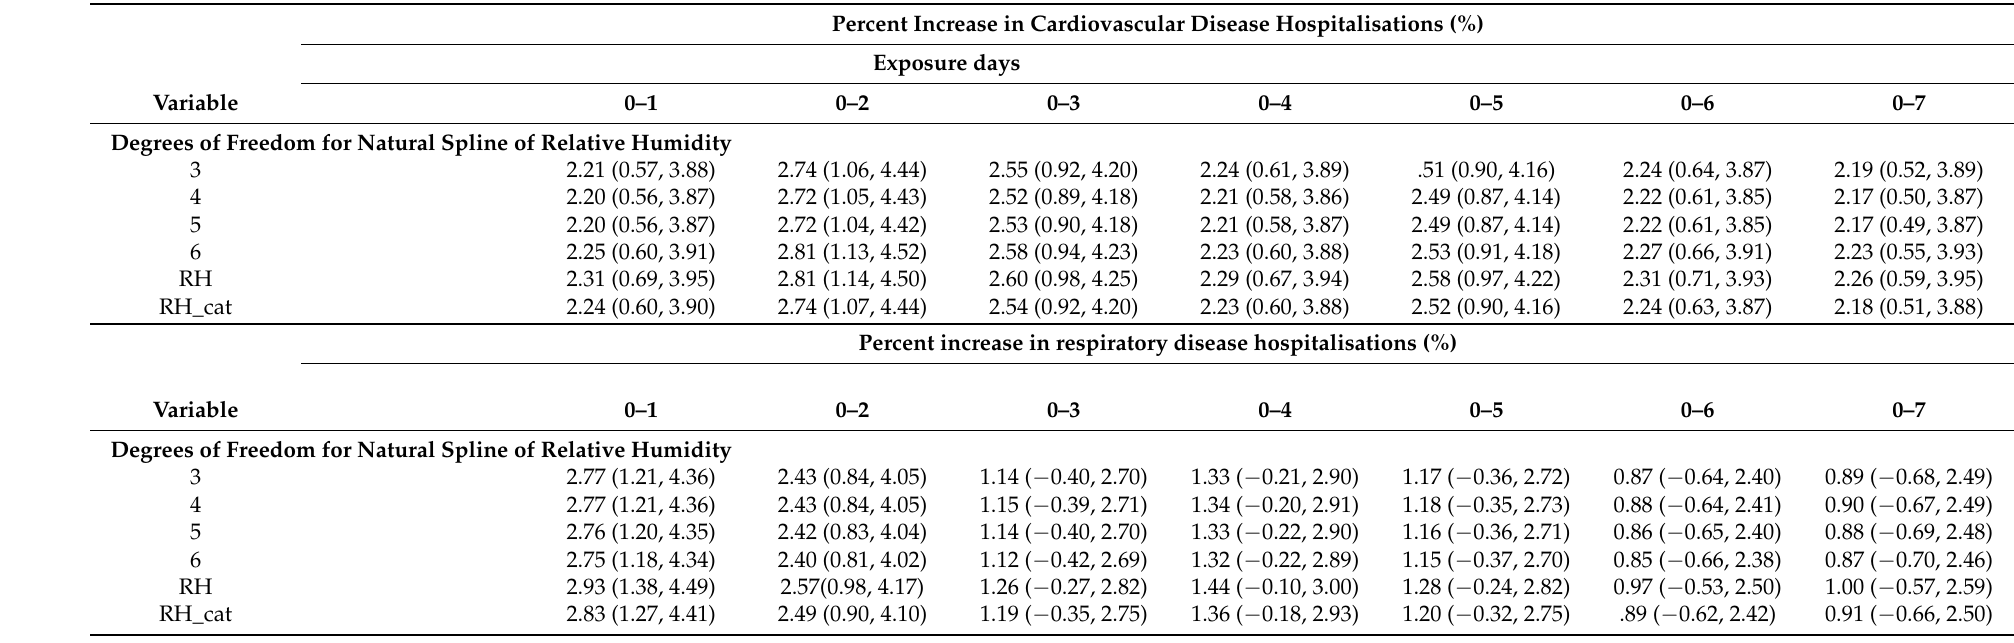
Table A4. Results of sensitivity analyses by changing the model options for relative humidity on the association between TV, and cardiovascular and respiratory disease hospital admissions on all exposure days for all ages. The results were scaled per IQR increase in